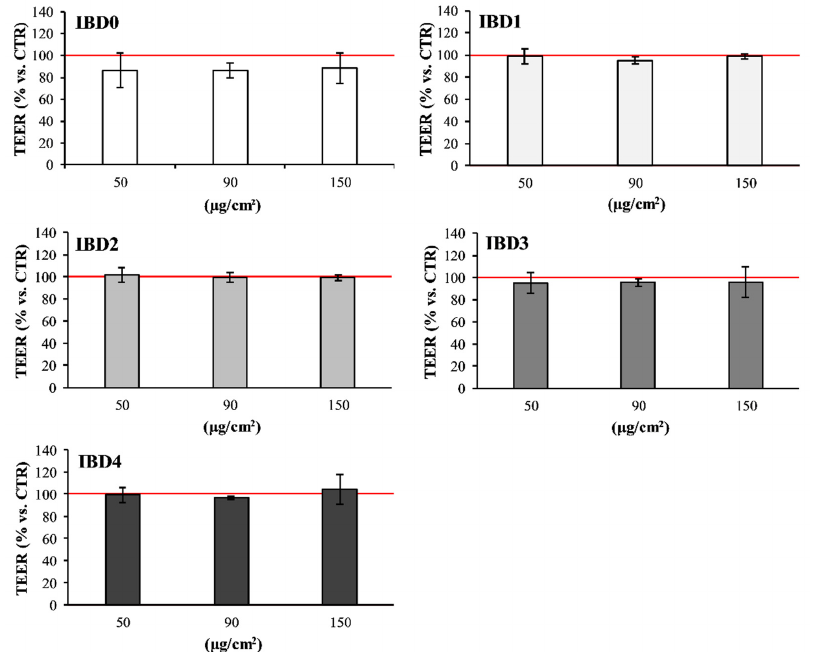
Figure 2. Intestinal 70% Caco-2/30% HT-29 co-culture TEER after incubation with IBDs. The graphs in the figure represent the monolayer integrity of intestinal co-culture cells after the incubation with 50, 90, and 150 µg/cm 2 of IBD0, IBD1, IBD2, IBD3, and IBD4. The viability is expressed as % vs. CTR (100), represented as a red line. Each % comes from the average of two independent experiments, each with at least two replicates. Foods 2020 , 9 , x FOR PEER REVIEW